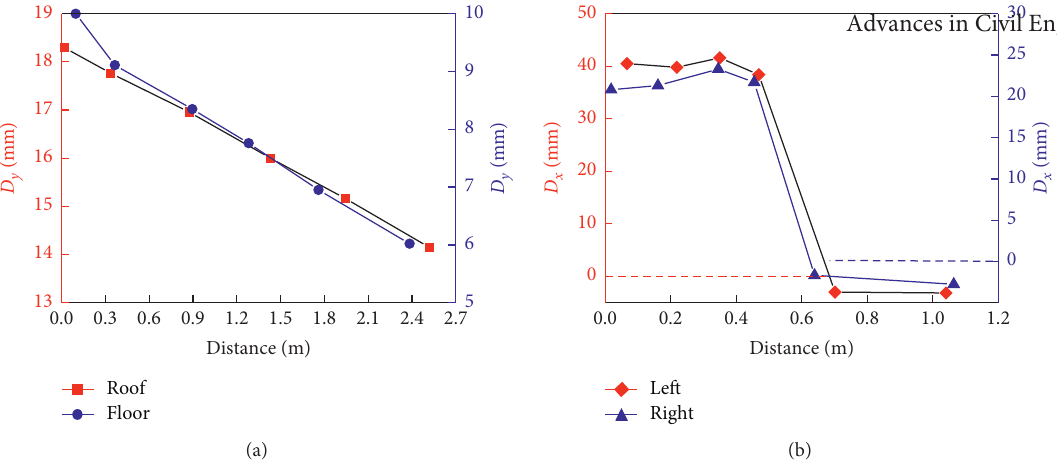
Figure 13: Summary of roof and floor displacements with distance from the roadway surface. (a) Vertical displacement toward the roadway ( D y ). (b) Horizontal displacement toward the roadway ( D x ).